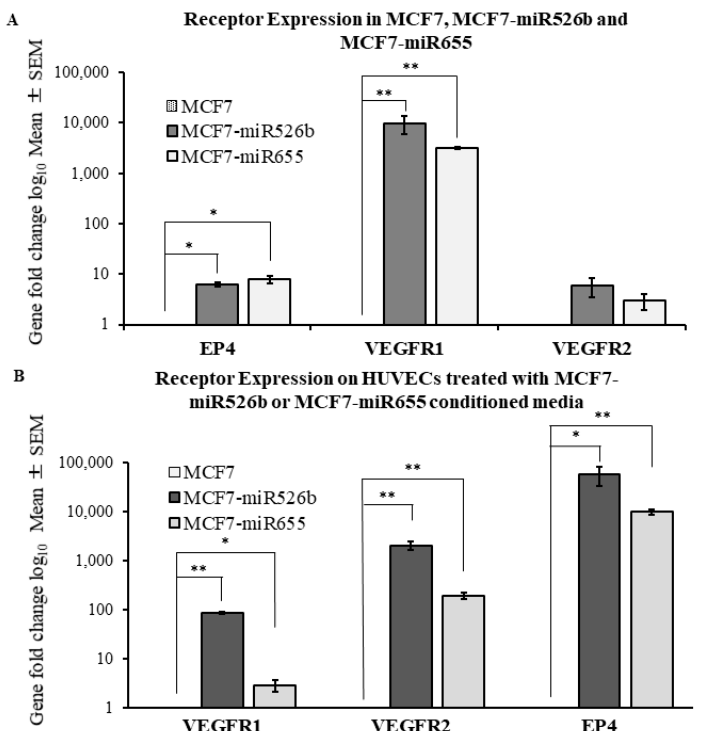
Figure 2. Overexpression of miR526b and miR655 in MCF7 or treatment of human umbilical vein endothelial cells (HUVECs) with miRNA-conditioned media results in upregulation of angiogenesis and lymphangiogenesis receptor markers. ( A ) Quantitative RT-PCR analysis shows significant upregulation of prostaglandin E2 receptor 4 (EP4) , VEGF receptor 1 (VEGFR1) , and VEGFR2 expression in the MCF7-miR526b and MCF7-miR655 cell lines, when compared with MCF7. ( B ) Quantitative RT-PCR analysis shows the HUVECs treated with MCF7-miR526b or MCF7-miR655 conditioned media have greater receptor gene expression compared with HUVECs treated with MCF7 conditioned media. RT-PCR quantitative data are presented as the mean ± SEM of triplicate replicates; * p < 0.05, ** p < 0.01.